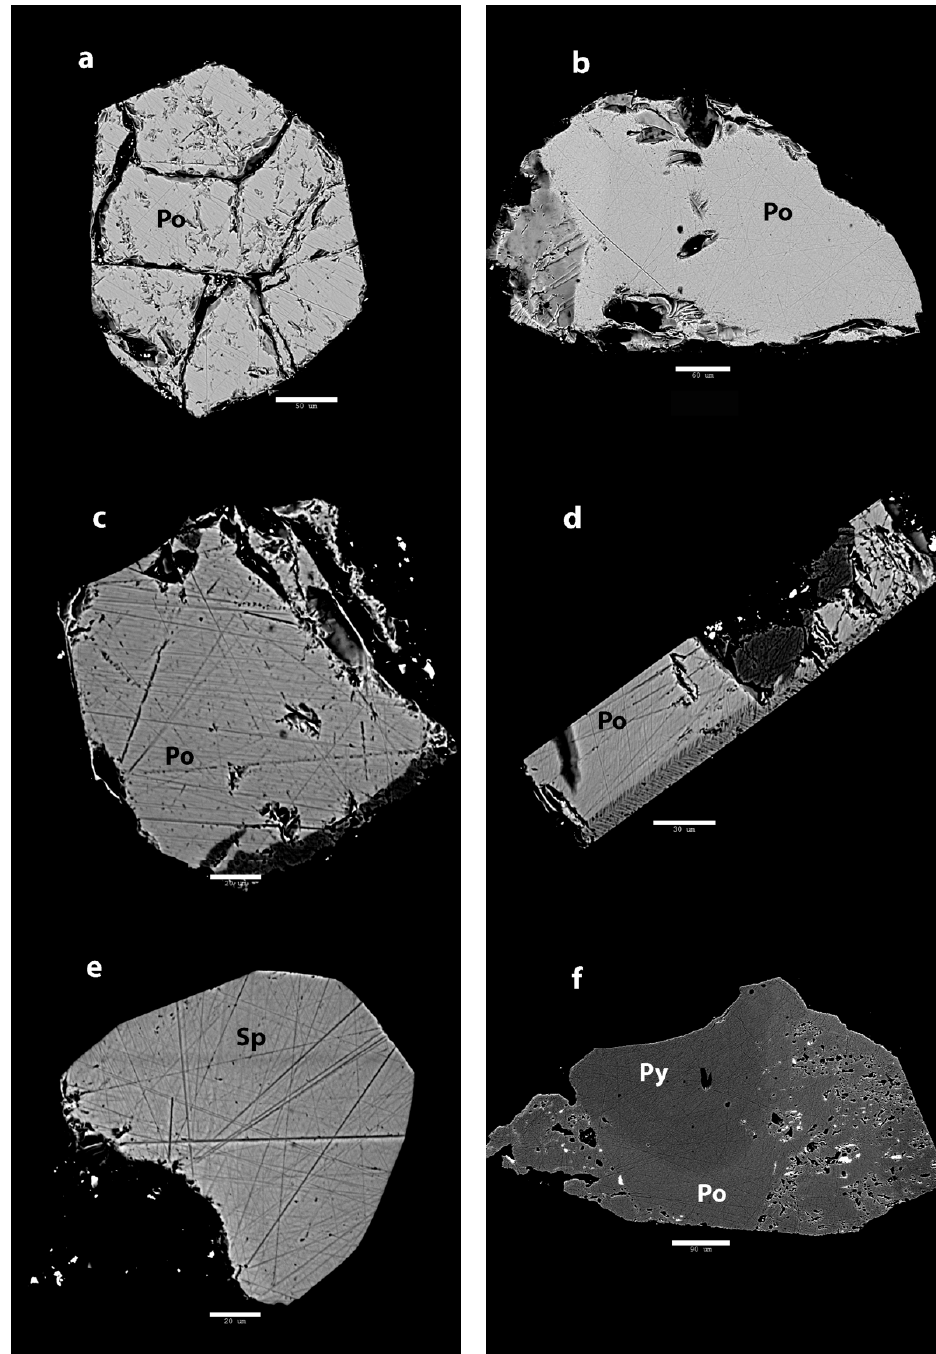
Figure 3. BSE images of Mogok rubies. ( a ) Inside sample A1, the inclusion shows hexagonal outline and large internal cracks. Scale bar: 50 µm; ( b ) The inclusion in sample A2 shows an irregular outline with a homogenous interior. Scale bar: 60 µm; ( c ) The inclusion in sample A3 shows straight outline with numerous polish lines. Scale bar: 20 µm; ( d ) Sample A4 also shows a lot of polish lines, but most notable is the herringbone texture on the side. Scale bar: 30 µm; ( e ) The inclusion in sample A5 has a well-defined outline on the top right. The bottom left has been removed during polishing. Apart from polishing lines, this inclusion appears very homogenous. Scale bar: 20 µm; ( f ) The opaque minerals attached to sample A6 show many pits but most important is the subtle zoning in the central part. The ruby is attached to the lower part. Scale bar: 90 µm.